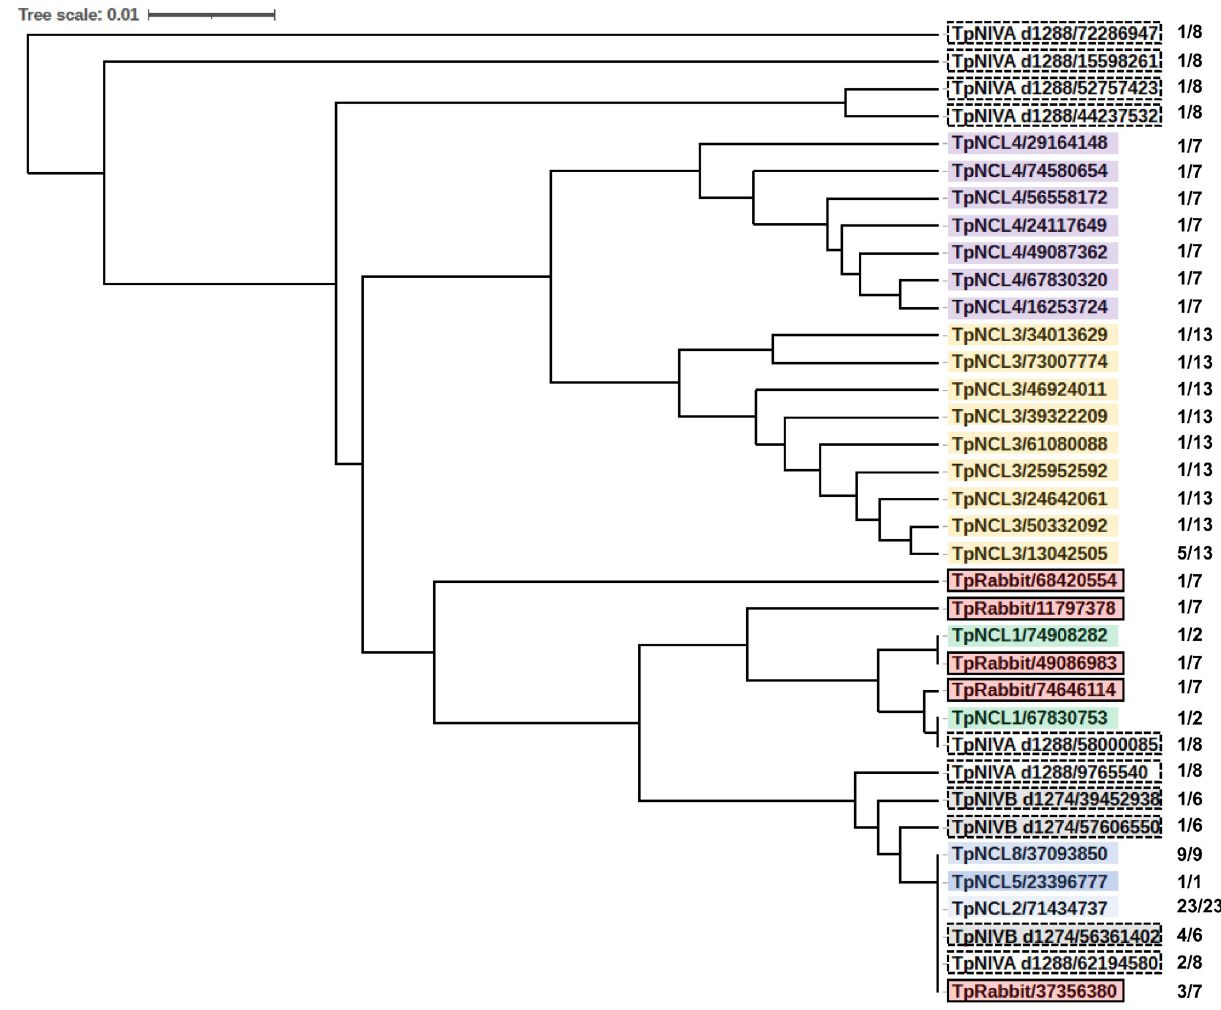
Fig 7. Relatedness of the full length tprK sequences of the T . pallidum Nichols clones and uncloned preparations. The nucleotide sequences of all available full length tprK sequences from PacBio CCS data were aligned, analyzed for relatedness using the UPGMA algorithm, and then depicted as an unrooted phylogenetic tree. The sequences from each clone are color coded; the rabbit-derived preparation is marked by red boxes, whereas the in vitro culture preparations are in shaded, dashed boxes. The PacBio identification number of a read for the sequence is included in each box; these are the same as the read IDs in S1 and S2 Figs. The numbers at the far right indicate the number of identical reads over the total number of available full-length tprK reads from that DNA preparation. The results indicate that the sequences from each of the clones are closely related, consistent with their derivation from a single precursor tprK sequence. In addition, identical full length tprK sequences were detected for clones TpN-CL2, TpN-CL5, and